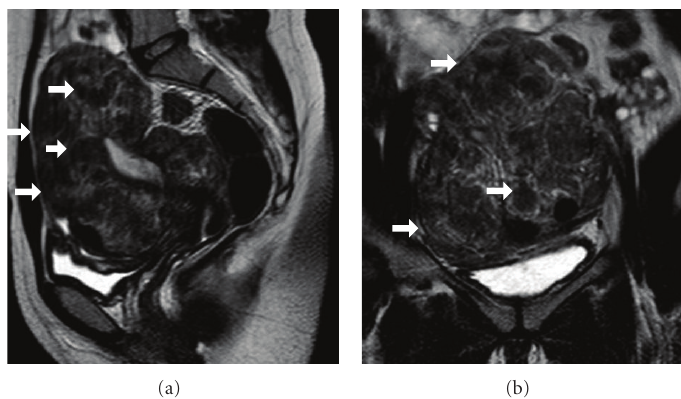
Figure 4: Followup MR imaging study—two years after surgery. Sagittal (a) and coronal (b) T2-weighted images reveal decrease of the uterine size. Multiple leiomyomas of low to intermediate signal intensity (arrows) are